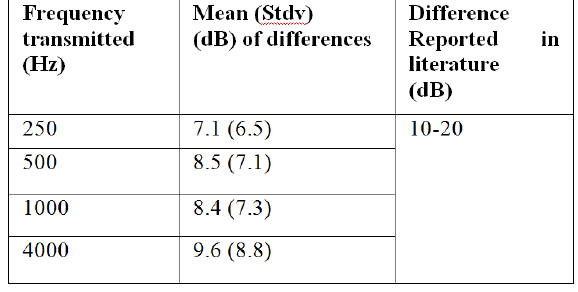
Table 1. Table showing statistics of difference in measured and modelled sound pressure levels for four frequencies.